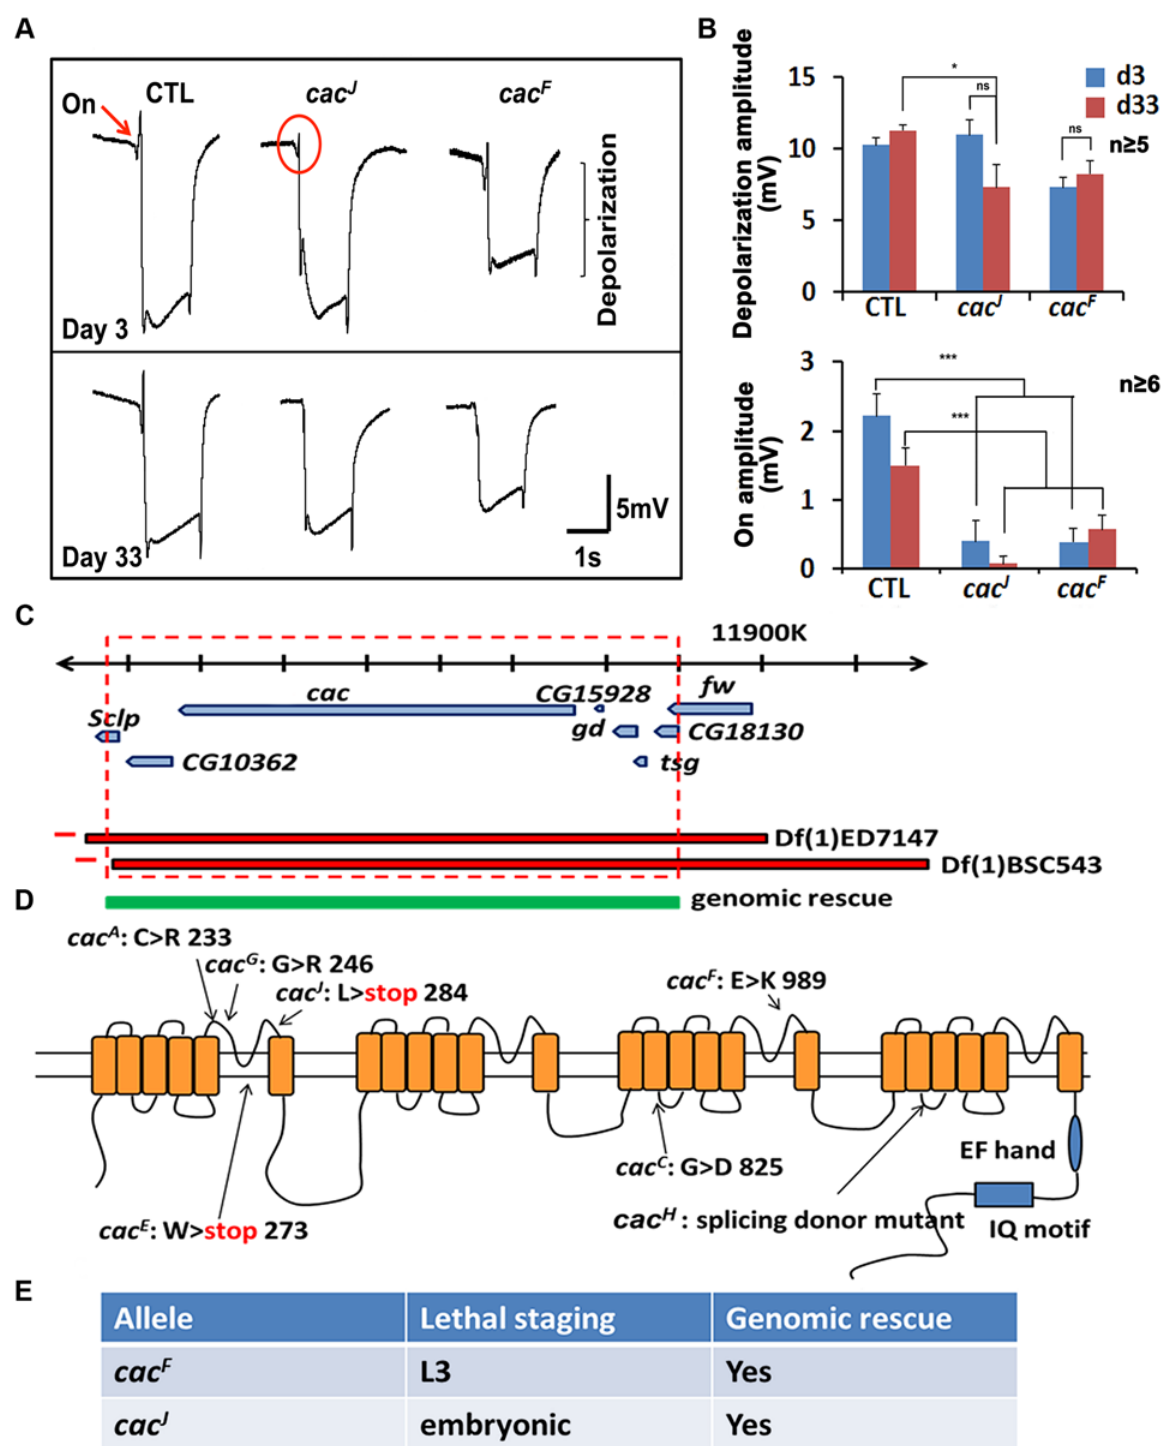
Fig 1. cac mutants show ERG defects. A. In response to a 1 s light pulse, cac alleles lack on transients at day 3 and day 33. B. Quantification of depolarization amplitudes (top) and on amplitudes (bottom). Data are presented as means ± standard error of the mean (SEM). C. The cac alleles identified failed to complement deficiencies Df(1)ED7417 and Df(1)BSC543. The lethality was rescued by 80 kb BAC clone CH321 – 60D21, narrowing the candidate region down to the area in the red box. We then crossed the cac alleles to existing alleles of cac and show that they fail to complement each other. D. Schematic representation of the molecular lesions of cac alleles. E. Lethal staging of cac alleles.